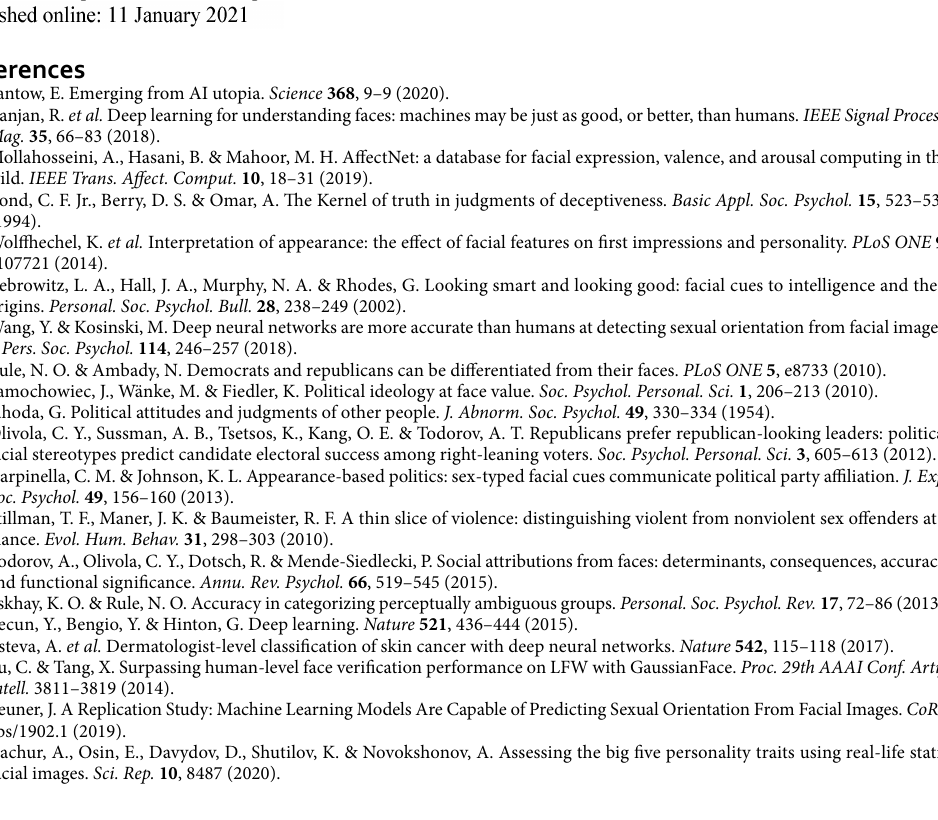
Classification algorithm. Classification employed L2-normalized face descriptors derived from facial images using the VGGFace2 model in ResNet-50 architecture, originally trained on an independent sample of over 3.3 million facial images 24 . We tested three approaches to measuring faces’ relative similarity to faces of liberal and conservative